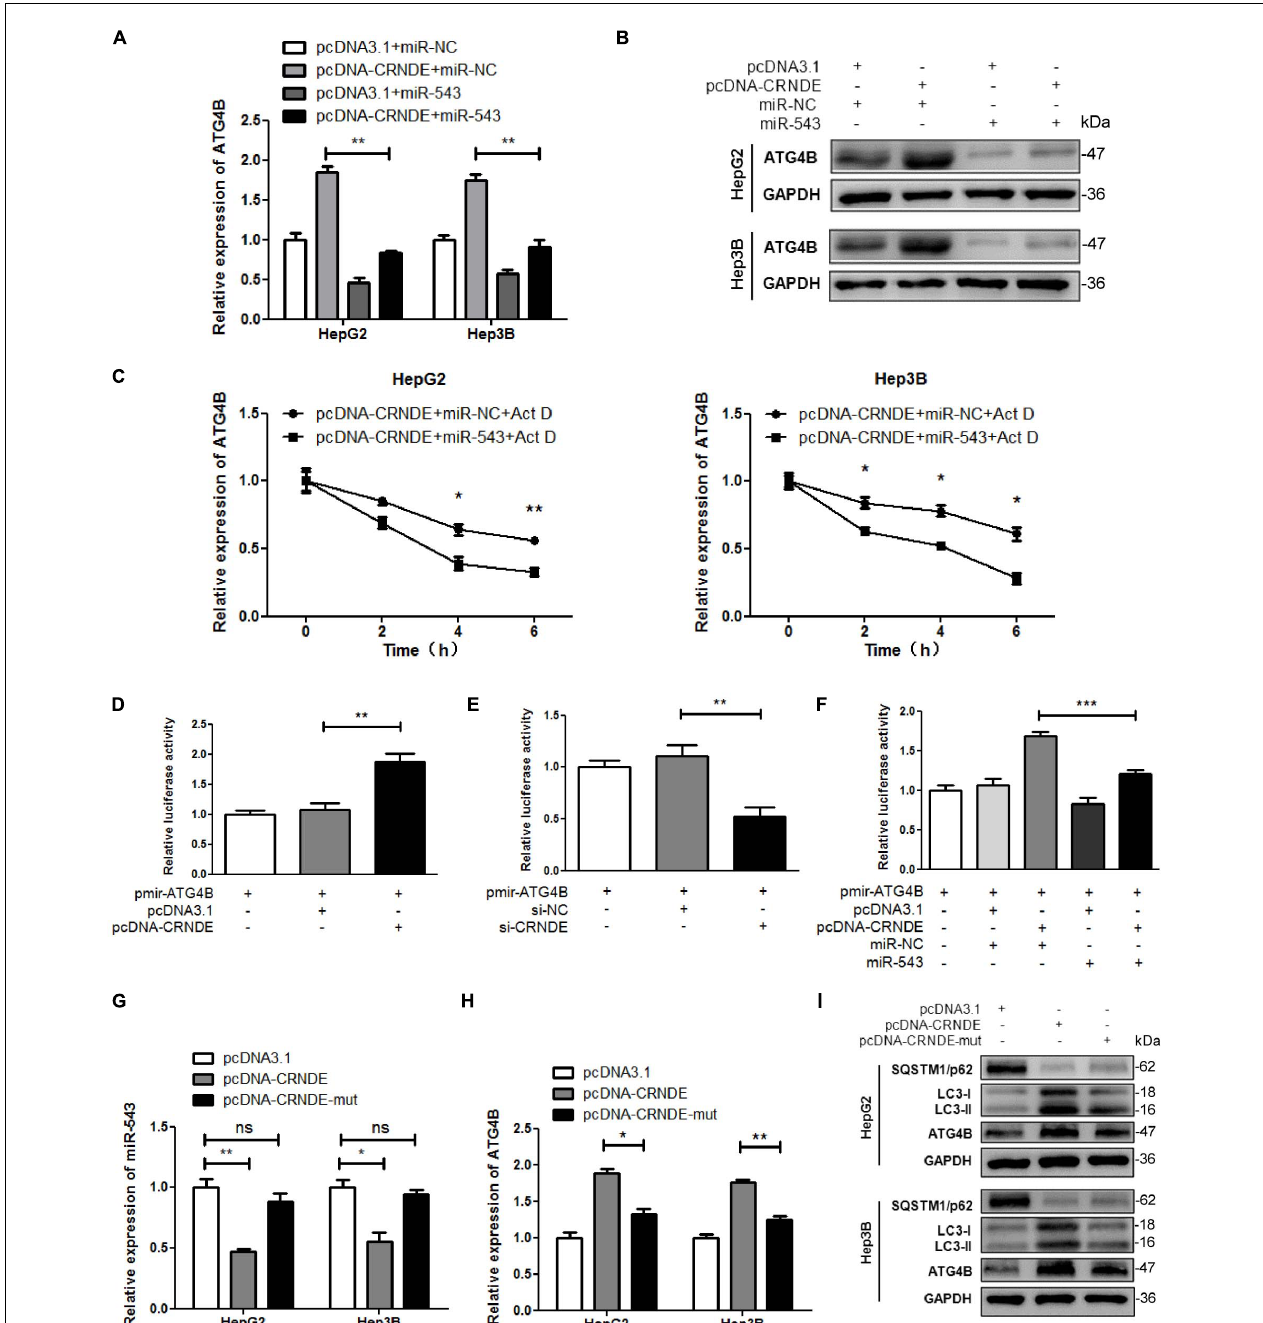
FIGURE 5 | CRNDE upregulates ATG4B and promotes autophagy through sequestrating miR-543. (A,B) HepG2 and Hep3B cells were co-transfected with pcDNA-CRNDE (or pcDNA3.1) and miR-543 mimics (or miR-NC) for 24 h, then the levels of ATG4B mRNA and protein were separately determined by qPCR (A) and Western blot (B) . (C) After co-transfected with pcDNA-CRNDE (or pcDNA3.1) and miR-543 mimics (or miR-NC) for 18 h, HepG2 and Hep3B cells were treated with 5 µ g/mL actinomycin D (Act D) for the indicated times, and then the level of ATG4B mRNA was quantified by qPCR. (D,E) HepG2 cells were transfected with pcDNA-CRNDE (or pcDNA3.1) (D) or si-CRNDE (or si-NC) (E) in the presence of pmir-ATG4B for 24 h. Then the luciferase activities were measured as described in Figure 4G . (F) HepG2 cells were co-transfected with pcDNA-CRNDE (or pcDNA3.1) and miR-543 mimics (or miR-NC) in the presence of pmir-ATG4B for 24 h. Then the luciferase activities were analyzed as described in Figure 4G . (G–I) HepG2 and Hep3B cells were separately transfected with pcDNA-CRNDE, pcDNA-CRNDE-mut, or pcDNA3.1 for 24 h. Subsequently, the levels of miR-543 and ATG4B mRNA were detected by qPCR (G,H) , and the level of ATG4B protein was examined by Western blot (I) . pcDNA-CRNDE-mut: the mutant CRNDE expression vector; pcDNA-CRNDE, pcDNA3.1, pmir-ATG4B, miR-NC, si-CRNDE, and si-NC were the same as the description in Figure 4 ; ns: no significance; * P < 0.05; ** P < 0.01; *** P < 0.001.